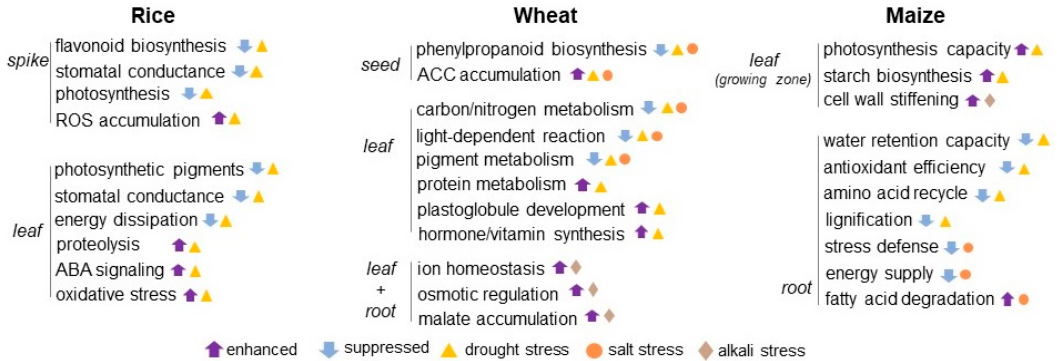
Figure 1. Crop proteomics in understanding signaling mechanisms under osmotic stress. The schematics of crop response to osmotic stress was constructed based on the proteomic studies on rice, wheat, and maize under drought, salt, and alkali conditions. The upward and downward arrows mean enhanced and suppressed metabolisms induced by osmotic stress. Triangle, circle, and diamond indicate drought, salt, and alkali stress, respectively. ABA stands for abscisic acid; ACC stands for acetyl-CoA carboxylase; and ROS stands for reactive oxygen